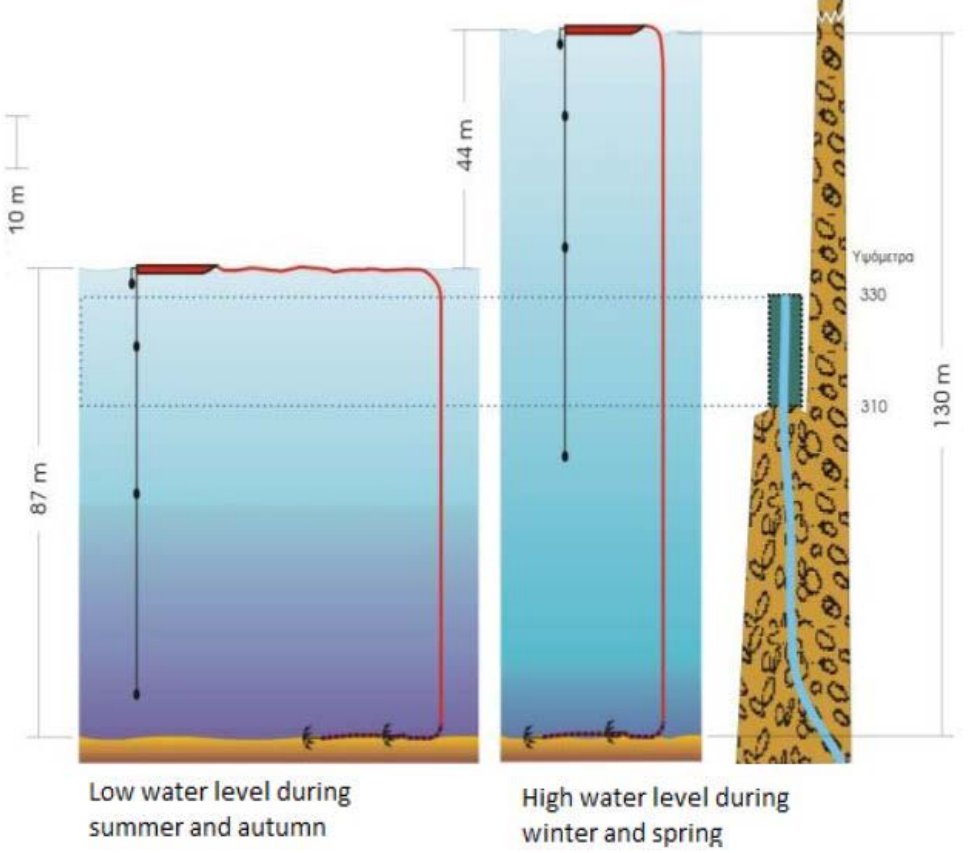
Figure 1. Thesaurus floating station and measurement depths during the year